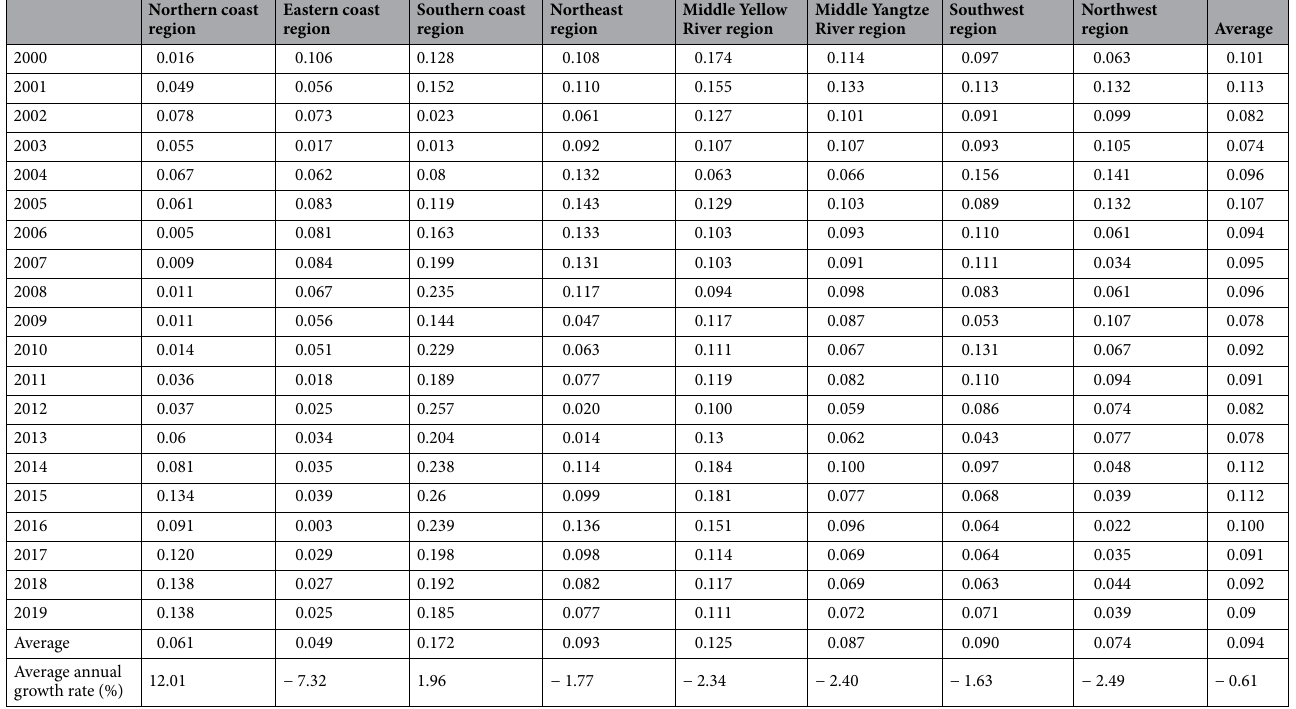
Table 4. The difference of CEEIE within